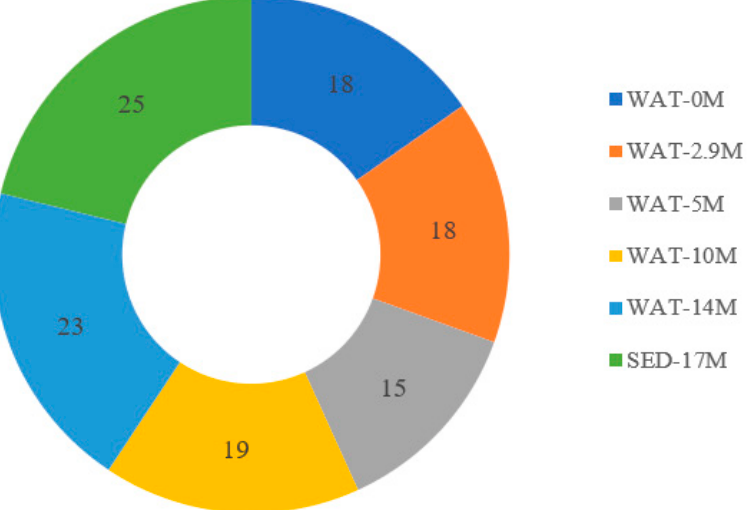
Figure 2. Number of nitrogen-fixing bacterial isolates obtained from each depth. WAT represents water sample and SED represents sediment sample.